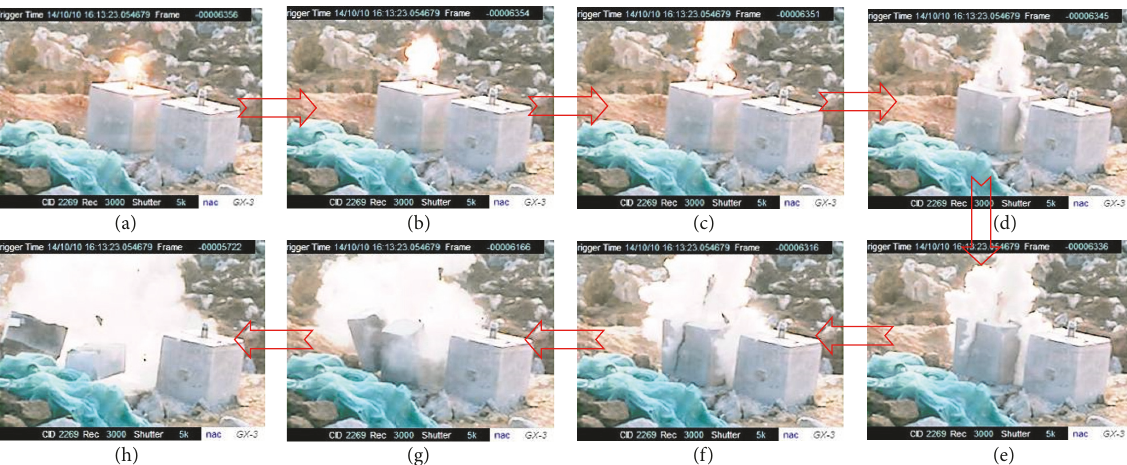
Figure 6: The process of ordinary blasting in the presence of air: (a) No. 6356; (b) No. 6354; (c) No. 6351; (d) No. 6345; (e) No. 6336; (f) No. 6316; (g) No. 6166; and (h) No. 5722